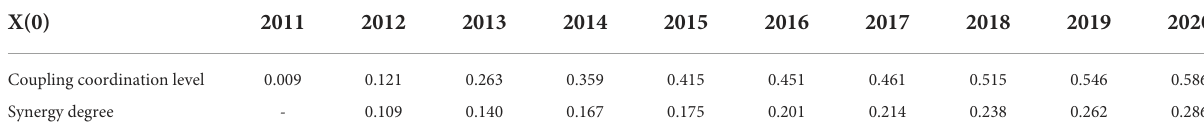
TABLE 10 Initial value of coupling coordination level and synergy degree.